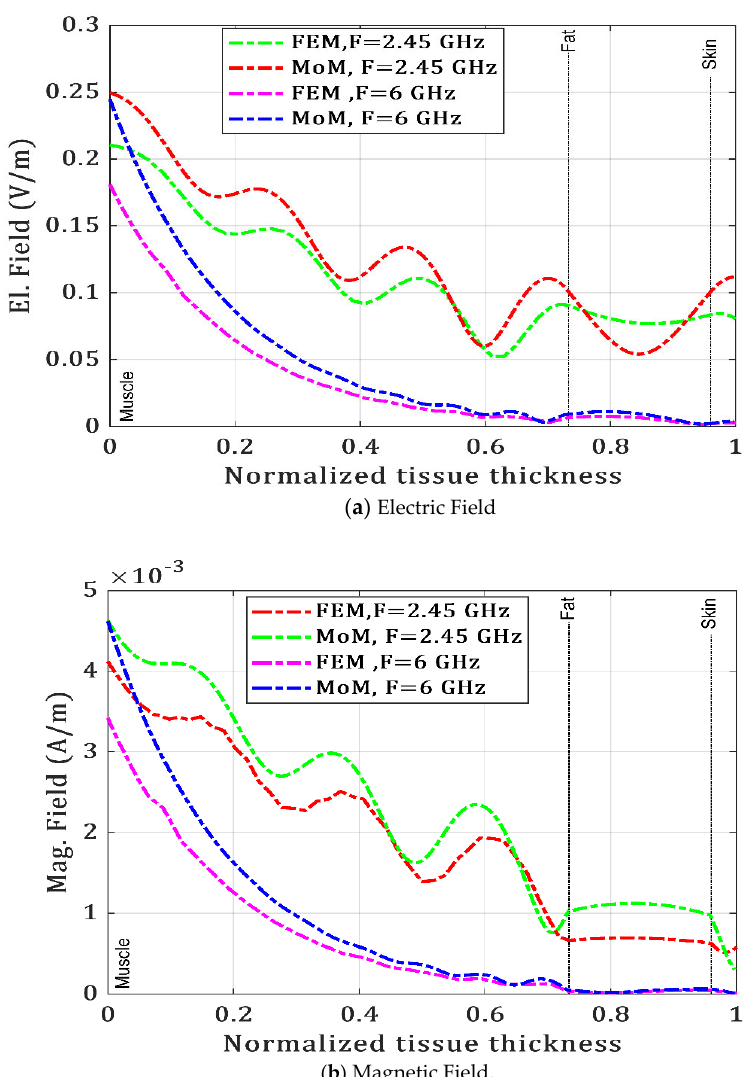
Figure 8. The EM field obtained by the MoM and FEM for IB2OB communication.